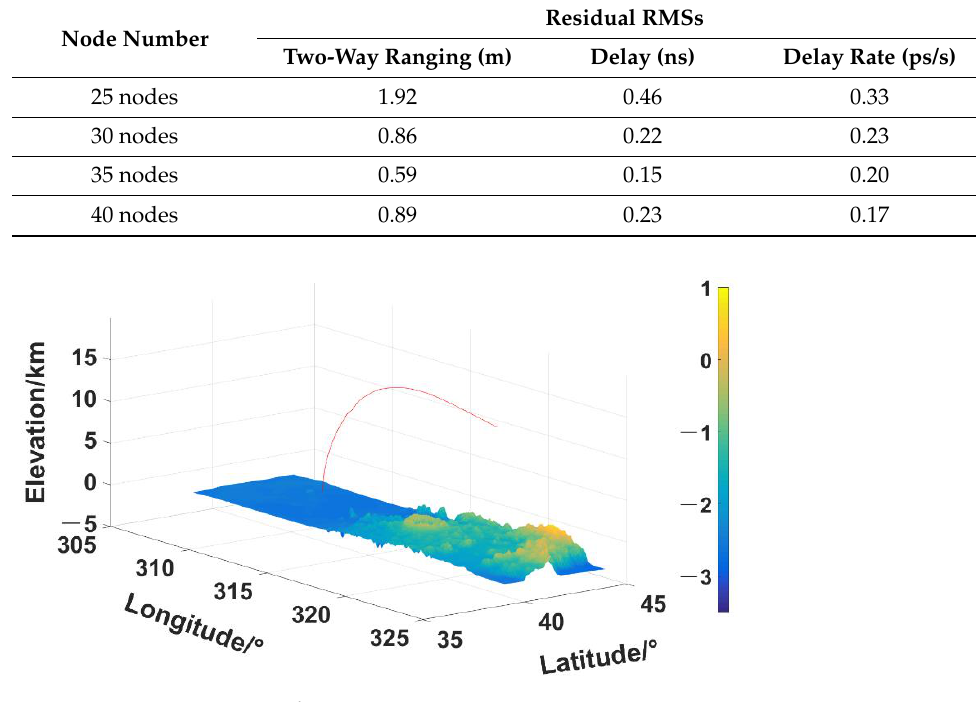
Figure 6. Ascent trajectory of CE-5.